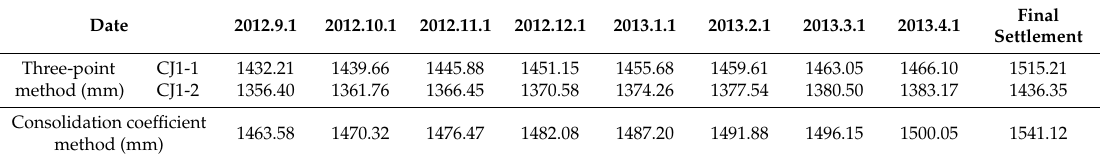
Table 2. The late settlement prediction.